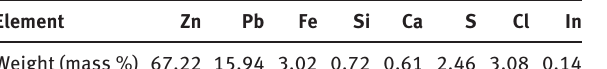
Table 1: The chemical compositions of zinc oxide dust (mass fraction,